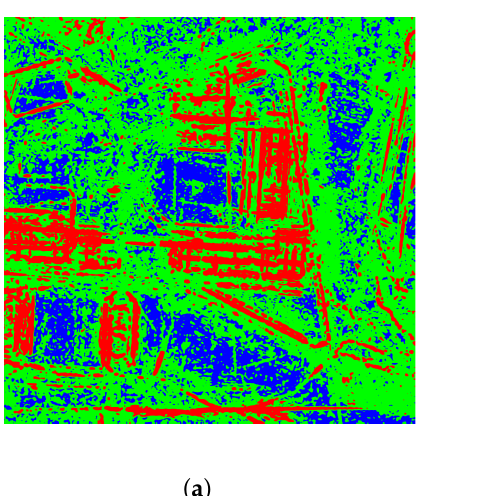
Figure 12. Classification of: ( a ) power station and buildings; and ( b ) an agricultural area using MAPE. Red: anisotropic targets; green: isotropic targets; blue: random